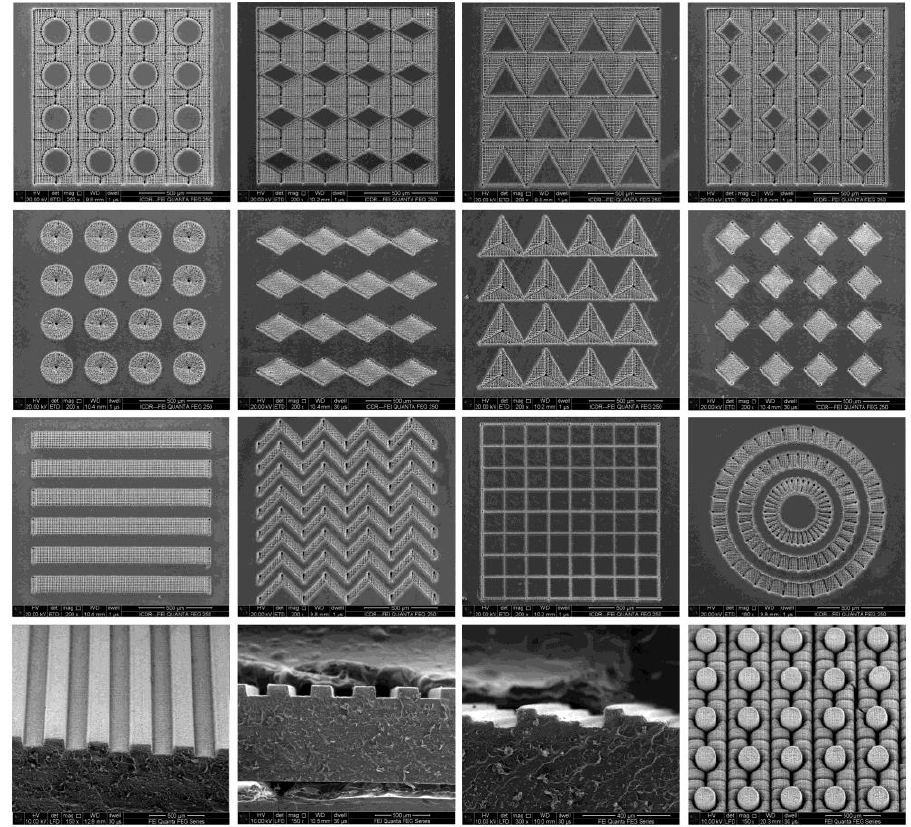
Figure 1. Various two-dimensional (2D) and three-dimensional (3D) structures formed by femtosecond (FS) laser surface structuring under various ablation conditions [32]. Reproduced with permission from [32] line 1–3 Copyrights Royal Society of Chemistry 2015. Line 4 copyrights Elsevier 2014.